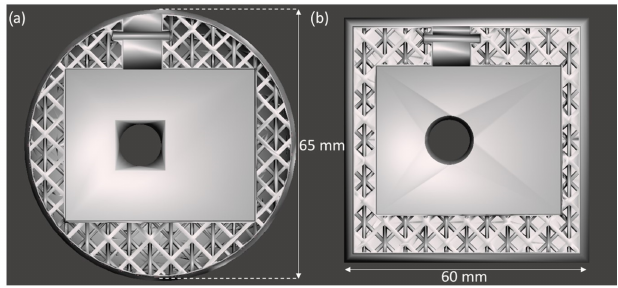
Figure 5. Lattice structure with different outer geometries: ( a ) sphere ( b ) cube.